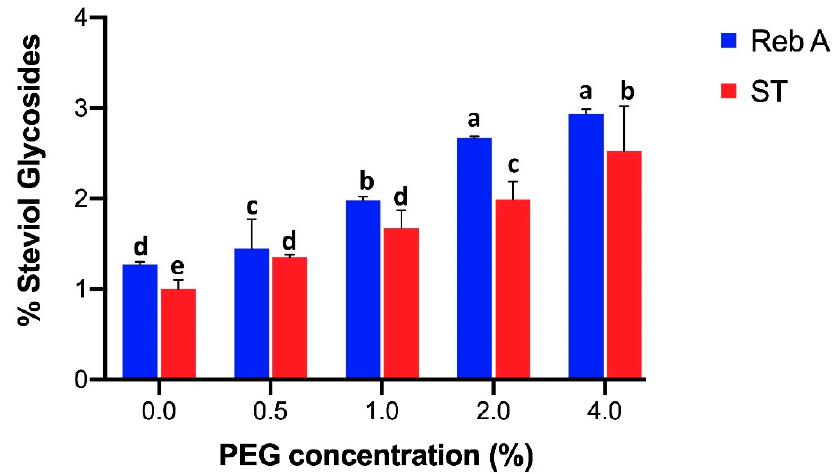
Figure 1. E ff ect of di ff erent PEG 6000 concentrations (0, 0.5, 1, 2, 4%) on shoots regarding rebaudioside A content represented with blue bars and stevioside content with red bars. For each parameter, bars with di ff erent case letters a–e are significantly di ff erent at the confidence interval level of 95% (Duncan’s multiple range test).